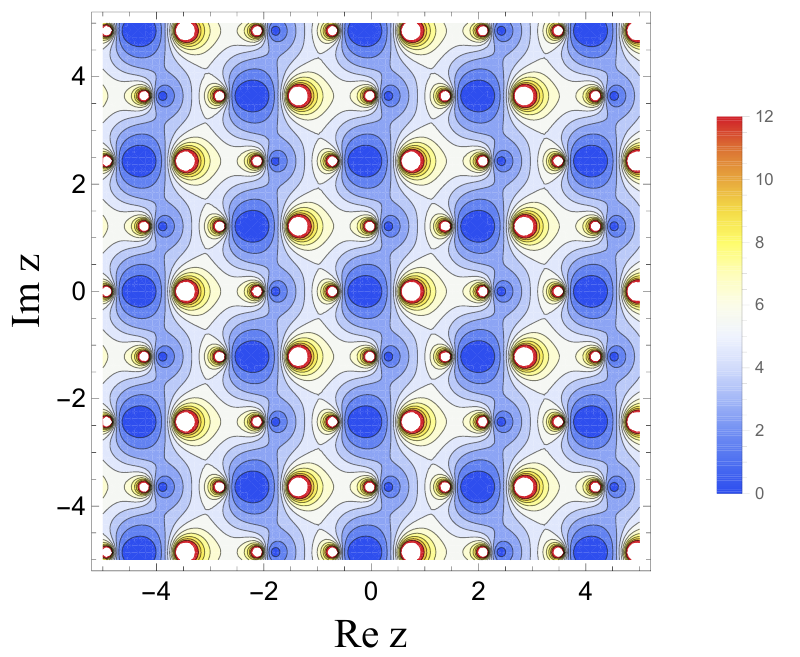
Figure 1 . The contour plot of j (cid:10)( z ) j = ( N (cid:0) 1) for the bi-quartic QFT (1.6) in the N ! 1